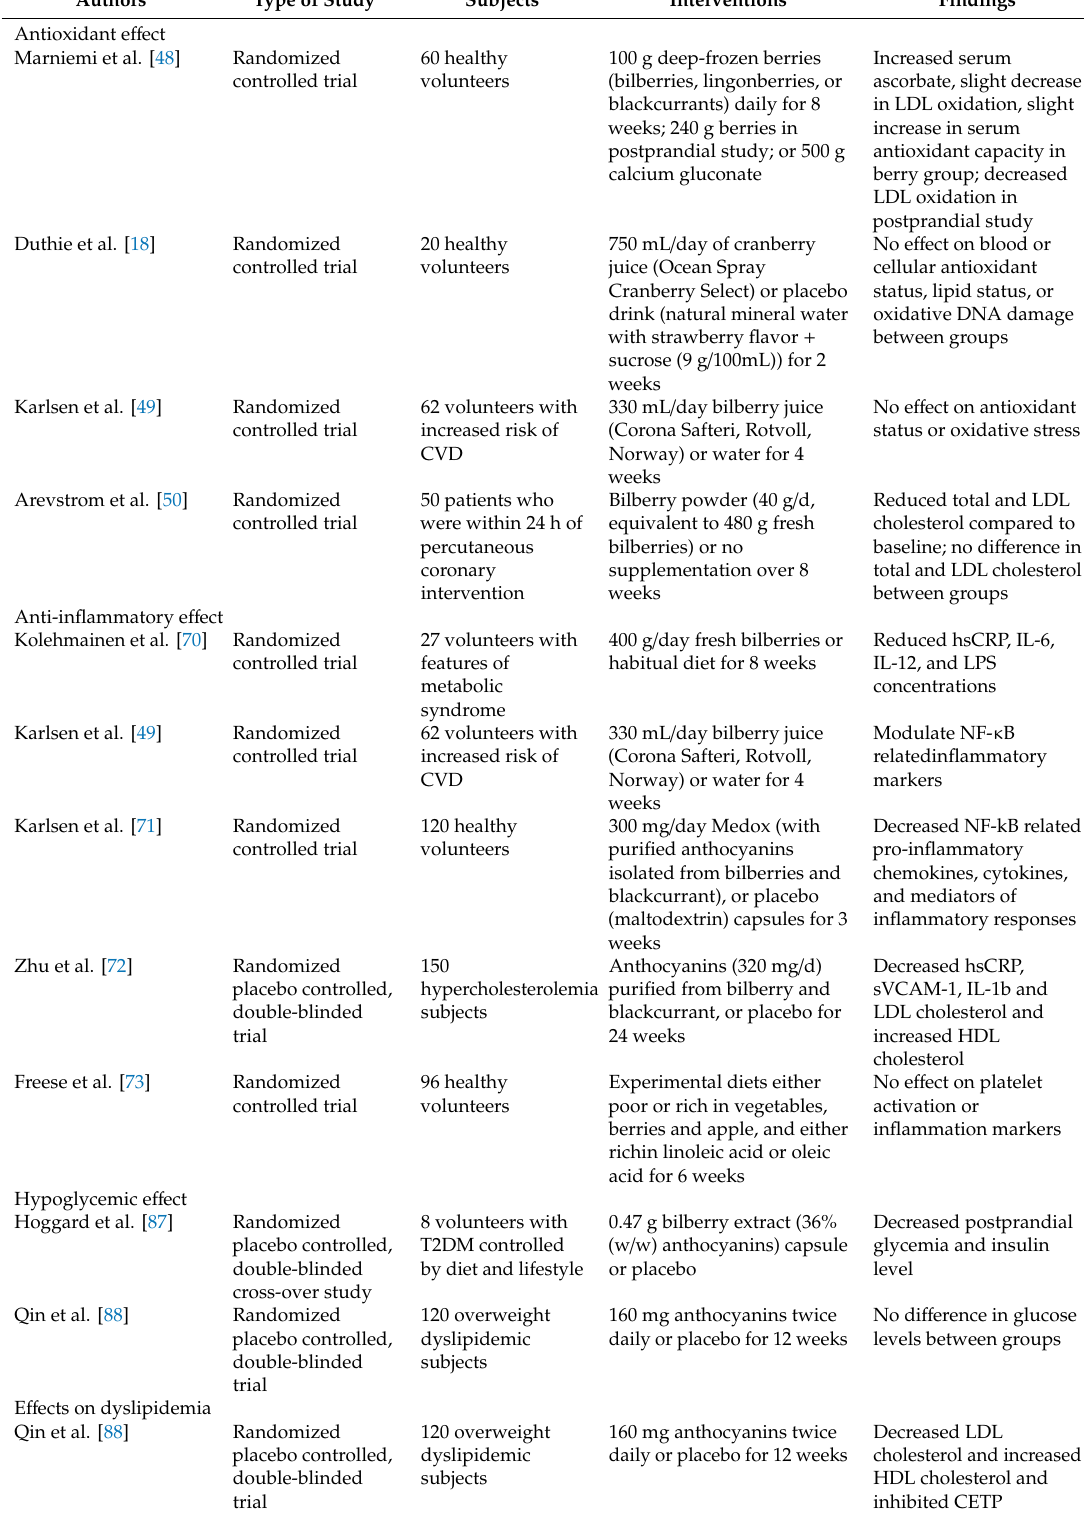
Table 1. Intervention studies of bilberry. LDL: low-density lipoprotein; hsCRP: high-sensitivity C-reactive protein; IL: interleukin; LPS: lipopolysaccharide; NF- κ B: nuclear factor- κ B; sVCAM-1: soluble vascular cell adhesion molecule-1; HDL: high-density lipoprotein; CETP: cholesteryl ester transfer protein; CVD: cardiovascular disease; T2DM: type 2 diabetes mellitus; CADP-CT: closing time in platelet function analyzer with collagen and ADP; FMD: flow-mediated dilation; cGMP: cyclic guanosine